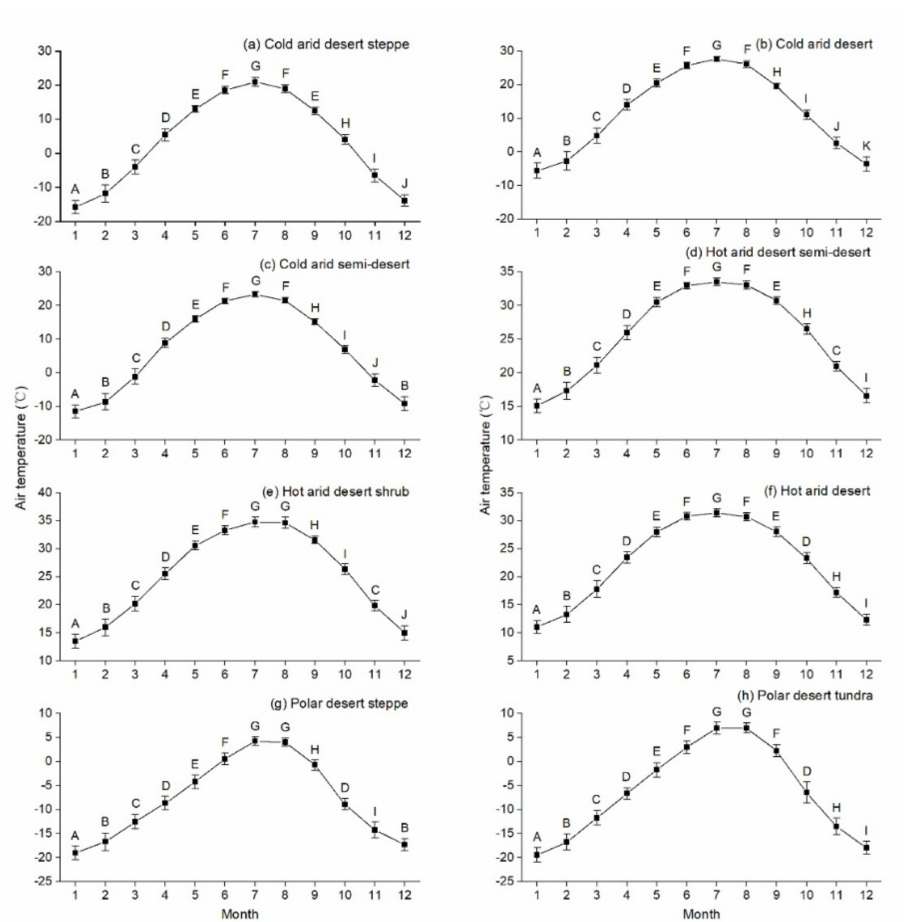
Figure 3. Variation of mean monthly air temperature in different desert areas over the Silk Road Economic Belt between 1982 and 2015. Different uppercase letters indicate significant differences between different months at p < 0.05. ( a – h ) indicate different desert areas,